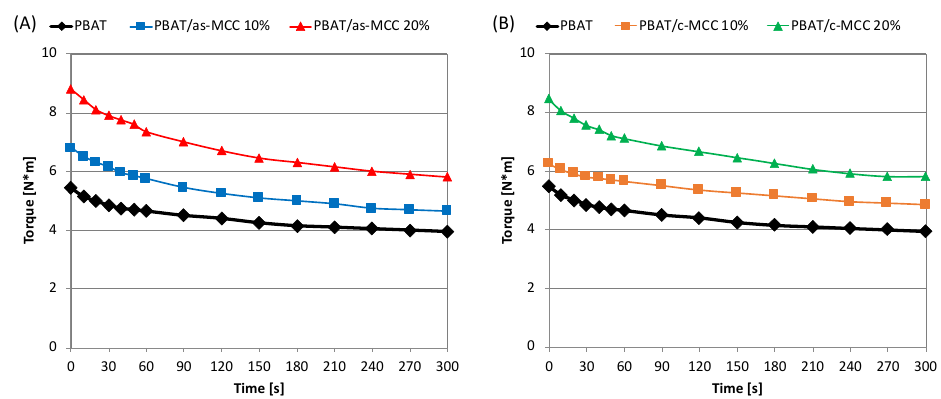
Figure 1. Torque as a function of time of ( A ) PBAT/as-MCC and ( B ) PBAT/c-MCC biocomposites.